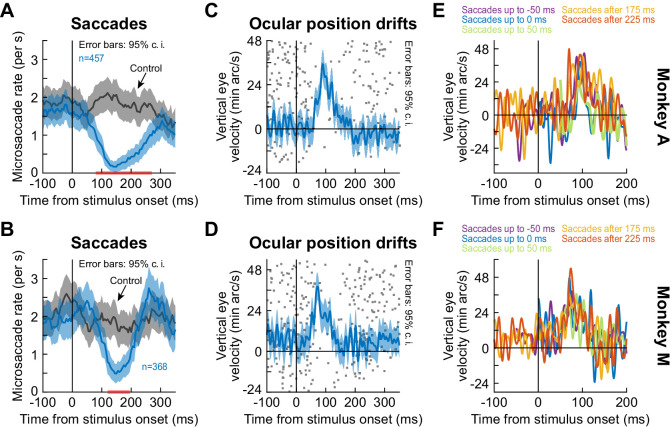
The ocular position drift response occurred during saccadic inhibition, and it also occurred even with nearby saccades.This figure is formatted identically to Figure 4. It shows similar results, but this time from the black fixation flash paradigm using full-screen flashes (the white fixation flash paradigm produced similar observations). (A, B) Microsaccade rate after full-screen flash onset in each monkey. The gray curve shows baseline microsaccade rate with no stimulus transient. (C, D) Ocular position drift response in each monkey during saccade-free fixation. To illustrate the timing of the drift response to saccadic inhibition, the dots indicate trial-by-trial rasters of microsaccade onset times during fixation. The drift response occurred when microsaccades were inhibited. (E, F) In each monkey, we inspected the ocular drift response when microsaccades still occurred near stimulus onset (different colors denote different microsaccade times as per the legends). The drift response still occurred, as in Figure 4 with another paradigm and the inclusion of a third monkey. Error bars are defined in the respective panels. All other conventions are similar to Figure 4.